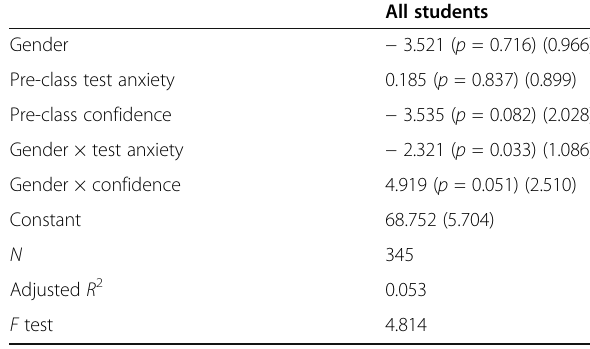
Table 3 Results of a model illustrating the impact of test anxiety, confidence, gender, and interactions on